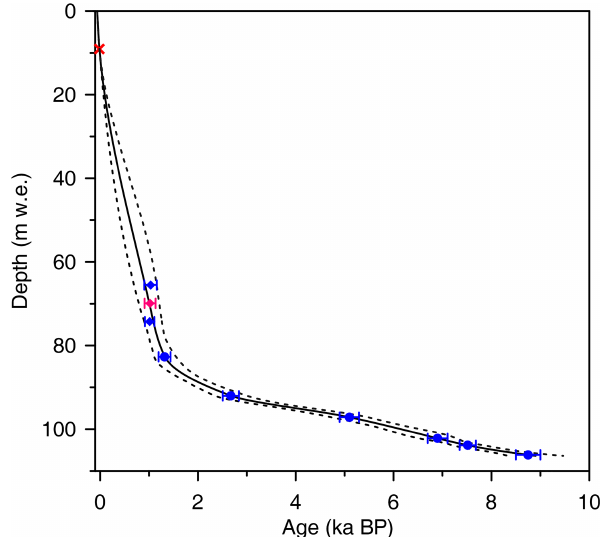
Figure 2. The age–depth relations of the ZK ice core based on 2000 Monte Carlo simulations fitting the absolute dated age horizons. Solid black lines indicate the mean values, and dotted lines indicate the 1 σ confidence interval. The red cross stands for the reference layer of the β activity peak in 1963 (An et al., 2016). Blue circles show the calibrated WIOC 14 C ages, and the red dot represents the average of the ZK-1 and ZK-2 ages at their average depth. Error bars represent the 1 σ uncertainty. Note that ZK1 and ZK-2 are not included in the Monte Carlo simulations, but both are located within the 1 σ confidence